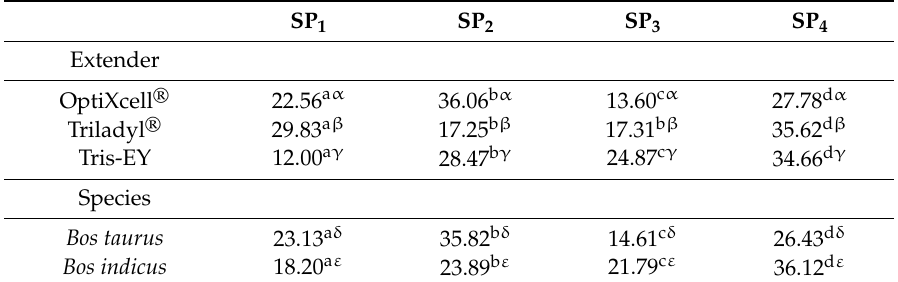
Table 7. Percentage of sperm cells from bulls Bos taurus and Bos indicus in each kinematic subpopulation characterized in semen diluted in three commercial